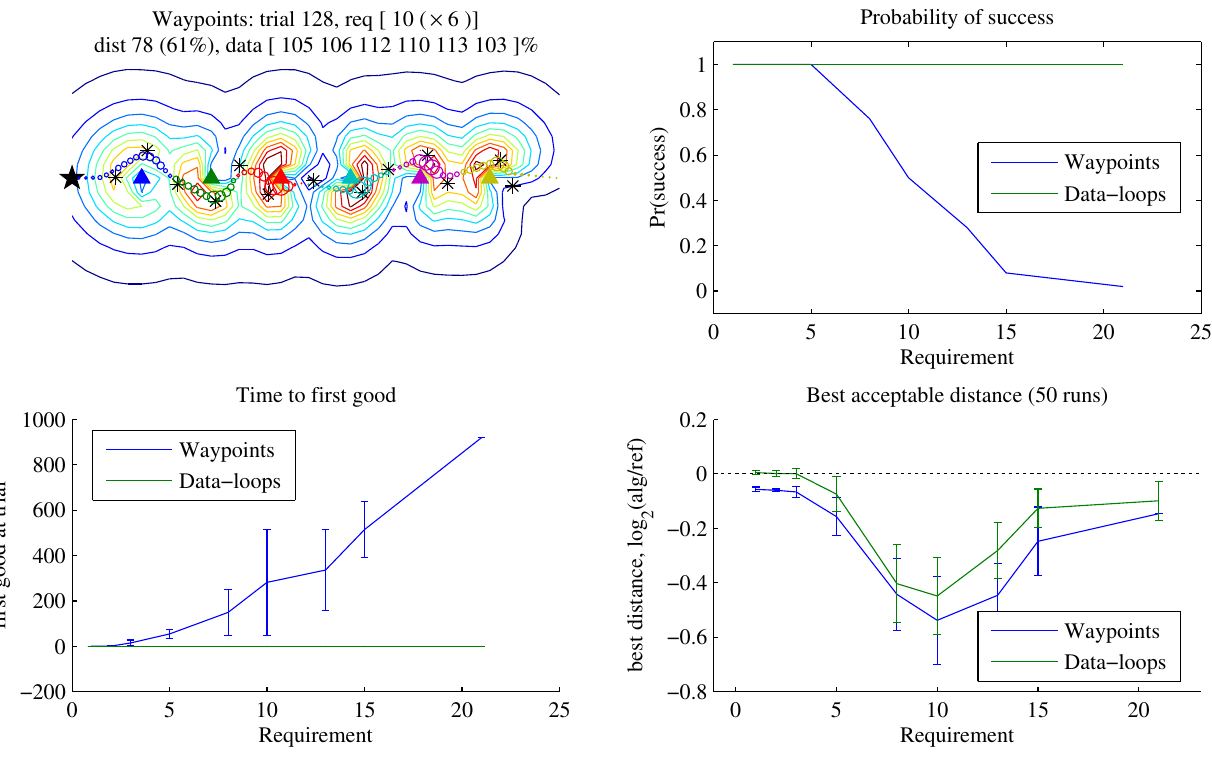
Figure 4. Data-loops vs . Waypoints as the data load increases, on a linear 6-node trajectory with nodes placed every 10. Otherwise as described in Figure